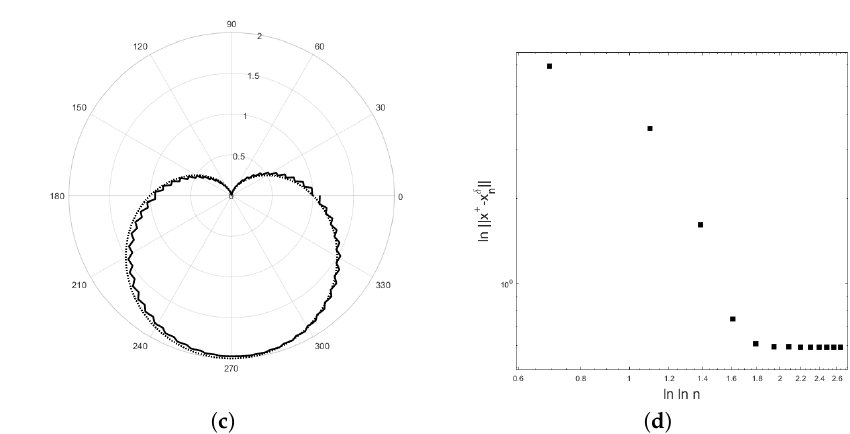
Figure 6. ( a ) The polar plot shows the exact solution (dot line) and the computed solution (solid line) for example 2 with ( a , b ) δ = 0.01 and ( c , d ) 0.001. In ( a ), the thin curve is an initial value. The error versus the logarithm of the number of iteration step using a double logarithm scale is x + x δ n (cid:107) − (cid:107) shown in ( b ) and ( d ). The initial value is x 0 = 1.6 1 ( 1000 + n ) − 0.9 2